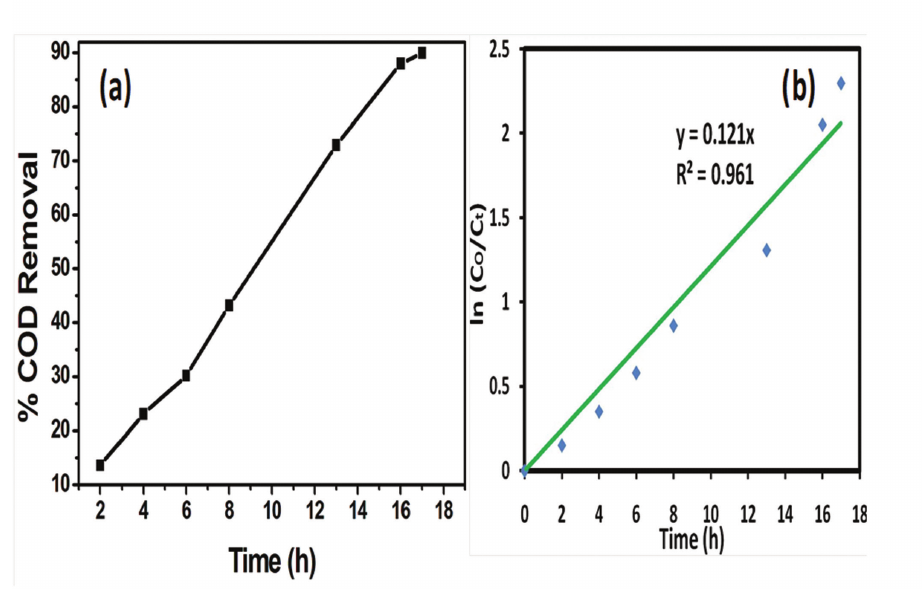
nanoparticles. 2